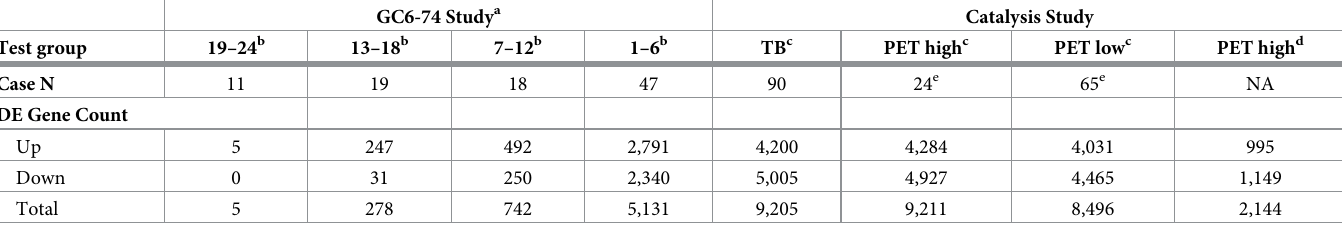
Table 2. Number of significantly differentially expressed (DE) genes (FDR < 0.05) at each time point.